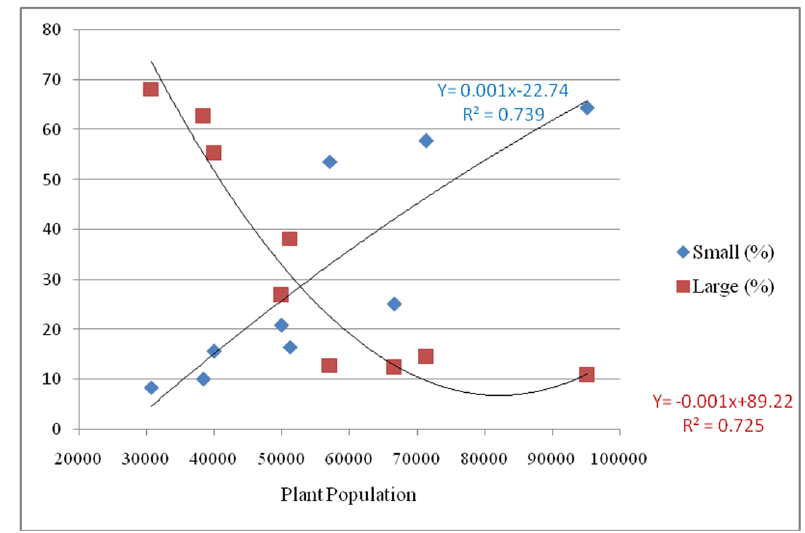
Figure 2: Cabbage head size distribution as a ff ected by plant population.